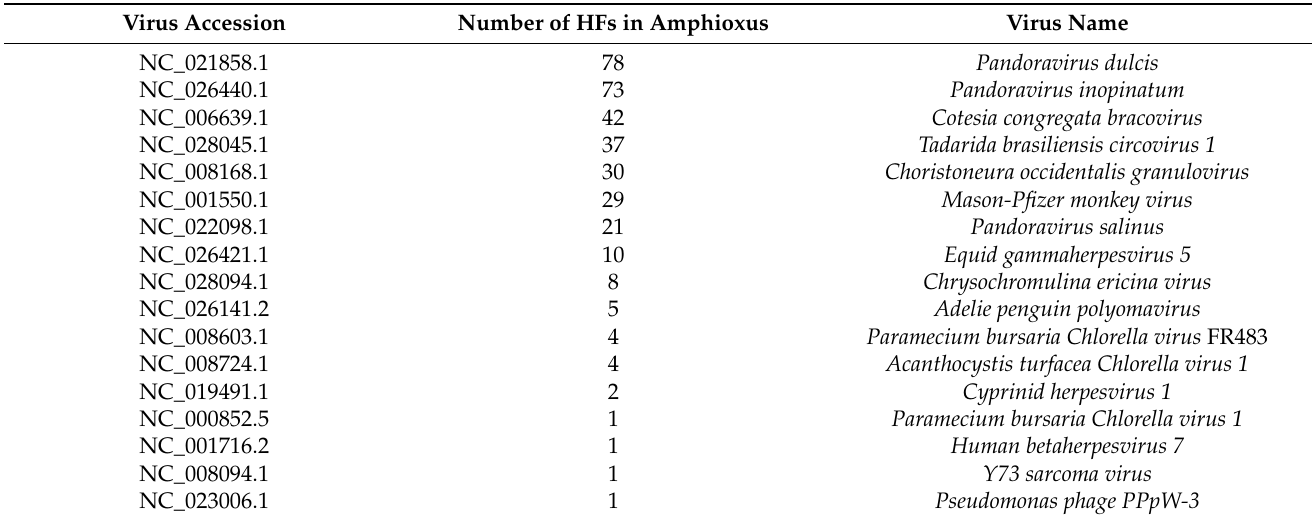
Table 1. Viruses homologous to B. belcheri beihai